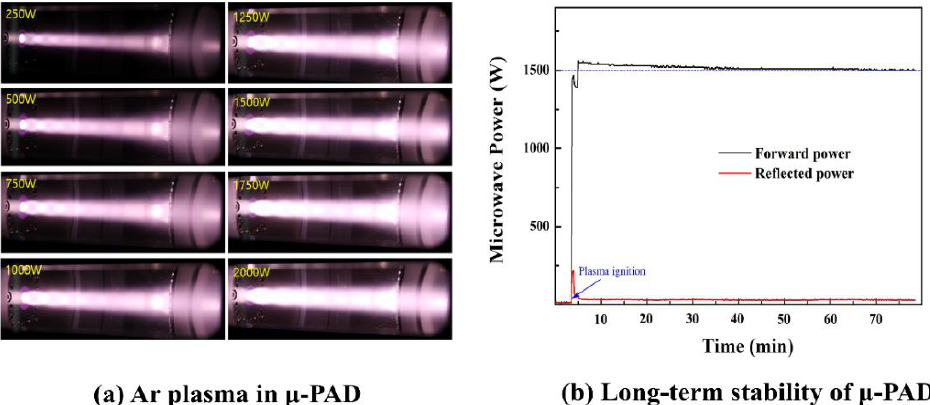
Figure 3. Argon plasma in the µ -PAD source operates at 1.7 Torr. Pictures were taken at several microwave power settings ( a ) from 250 W to 2000 W, and ( b ) test results of long-term stability are shown with the measured microwave